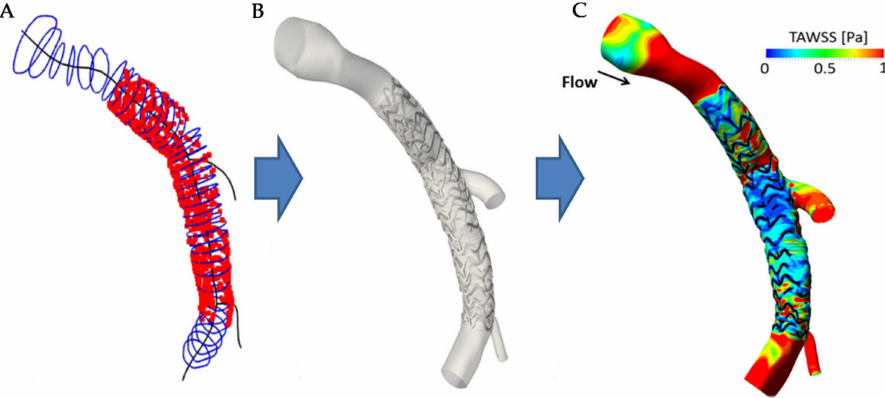
Figure 12. Layout of the presented model for stent strut segmentation. ( A ) The pseudo-3D polar image stack and manually annotated strut mask were taken as inputs. ( B ) Strut segmentation model composed of a start module, six encode and decode modules and an end module. ( C ) The predicted strut map including orientation, width, and position of struts. Reprinted from [175], with permission, under the Creative Commons.